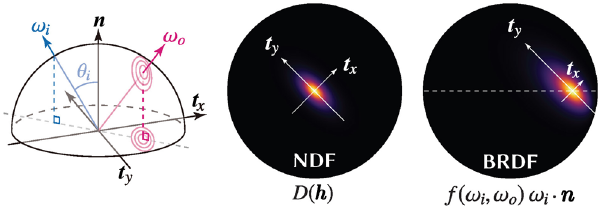
Fig. 2 Projected distributions for an NDF and corresponding BRDF are visualized. To evaluate the BRDF, we used the zenith angle π/ 4 of incident direction ω i , as shown in the image to the left. The principal axes for these distributions are the same, and the elliptic shape for the NDF is approximately preserved in that of the BRDF.